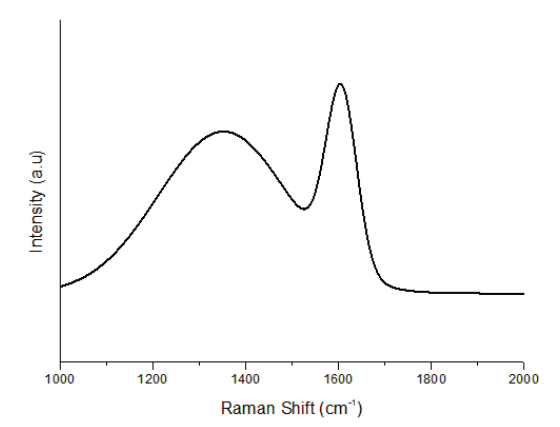
Figure 8. Raman spectrum of as-grown CNC